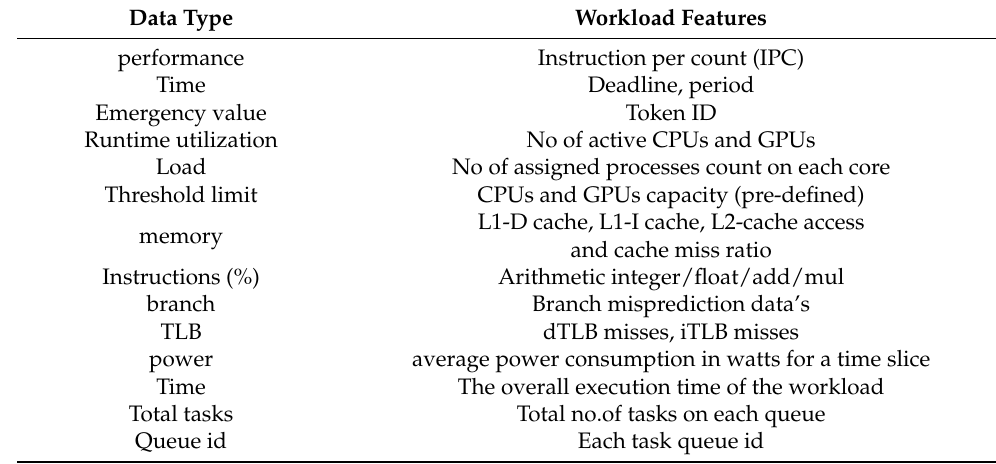
Table 2. Optimized Feature of Workloads [31].